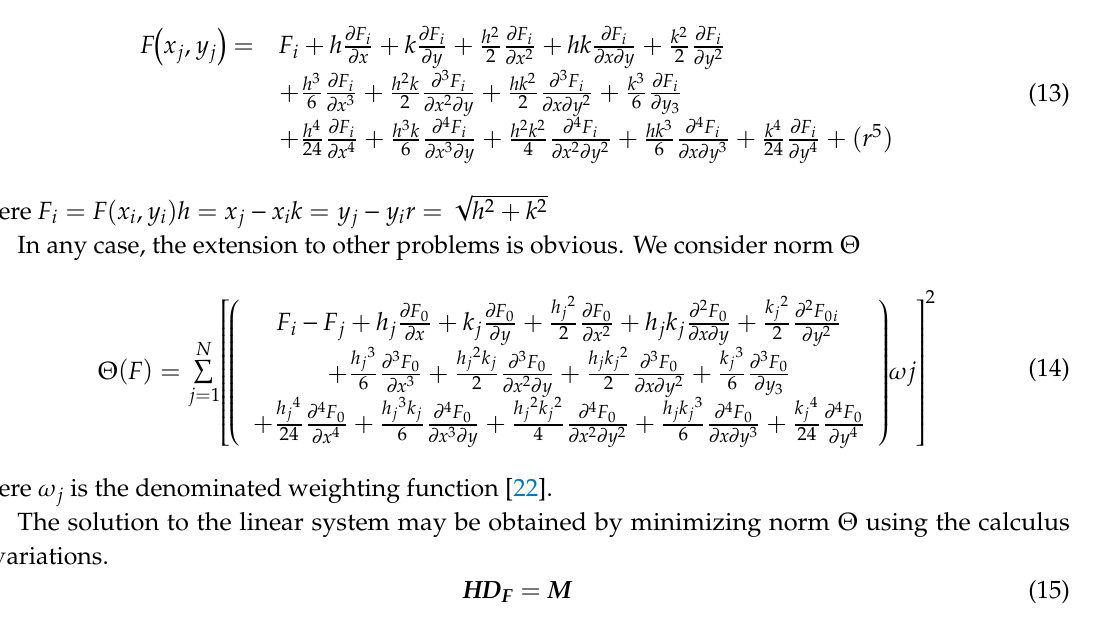
Figure 3. Schematic diagram of collocation nodes in the generalized finite difference method (GFDM).